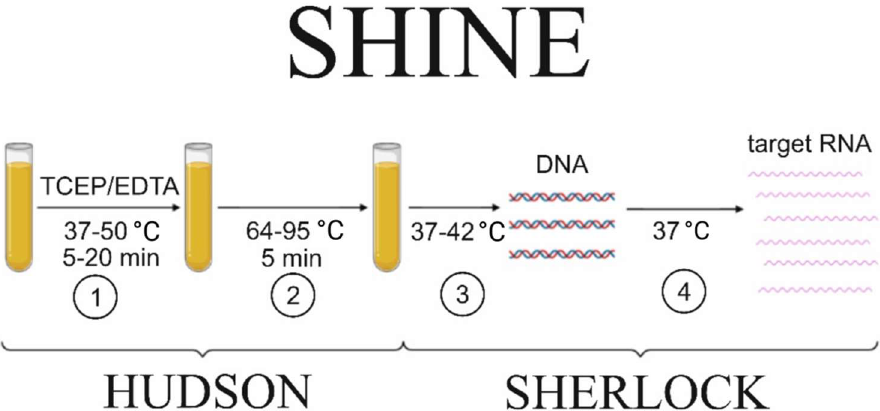
Figure 1. Scheme of viral particle detection in biological fluids using the SHINE protocol. The main steps are (1) nuclease inactivation to prevent nucleic acid degradation; (2) viral particle inactivation, facilitating the nucleic acid release from the particle; (3) RT–RPA step to amplify a sufficient amount of DNA; (4) target RNA production for the specific Cas13a-mediated detection. The steps that are included either in HUDSON or SHERLOCK protocols are indicated by the curly braces.